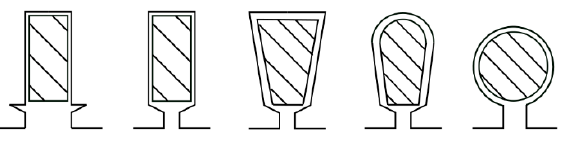
Figure 2. Various slot shapes.